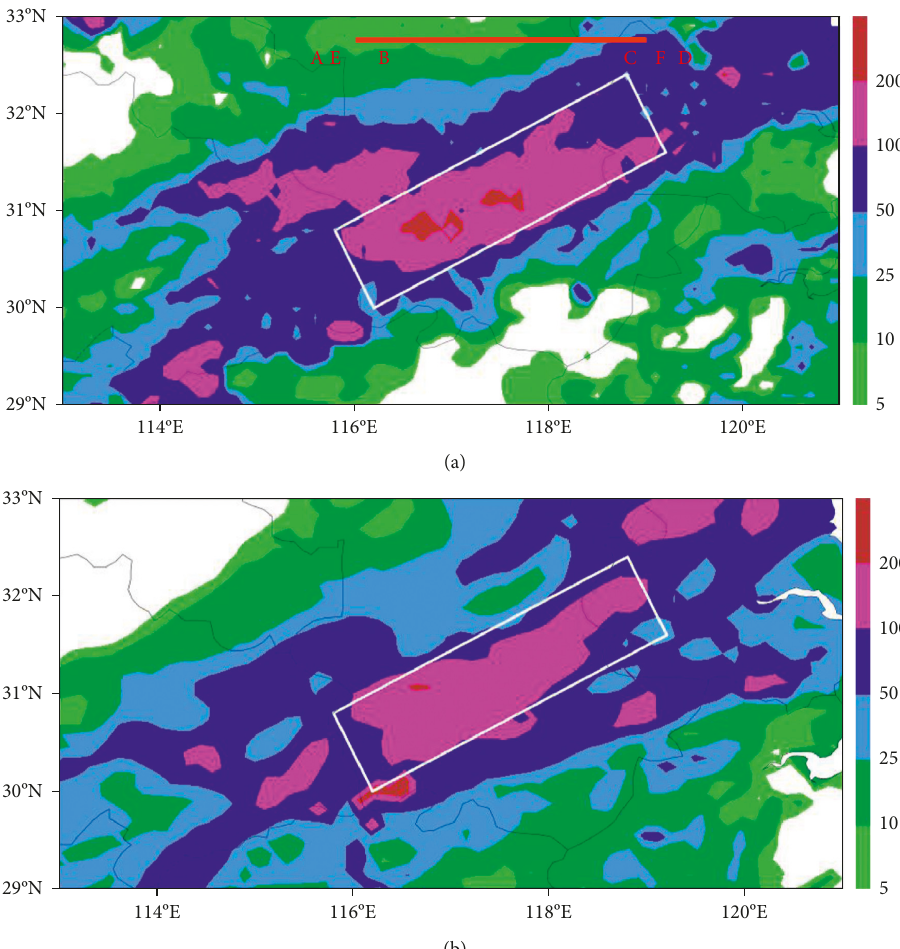
Figure 2: Observed (a) and simulated (b) 24h accumulative precipitation during 00 UTC 4 -00 UTC 5 July 2014. The white frame indicates the key area of the rainstorm (unit: